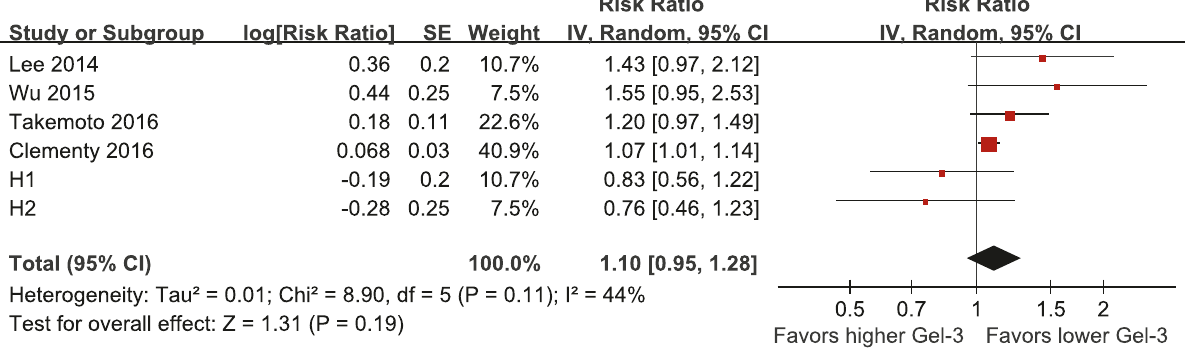
Figure 4: Forest plots showing the predictive efficacy of baselineGal-3 levels for determining the risk of AF recurrenceafter catheterablation after incorporating two imputed studies with “trim-and-fill”